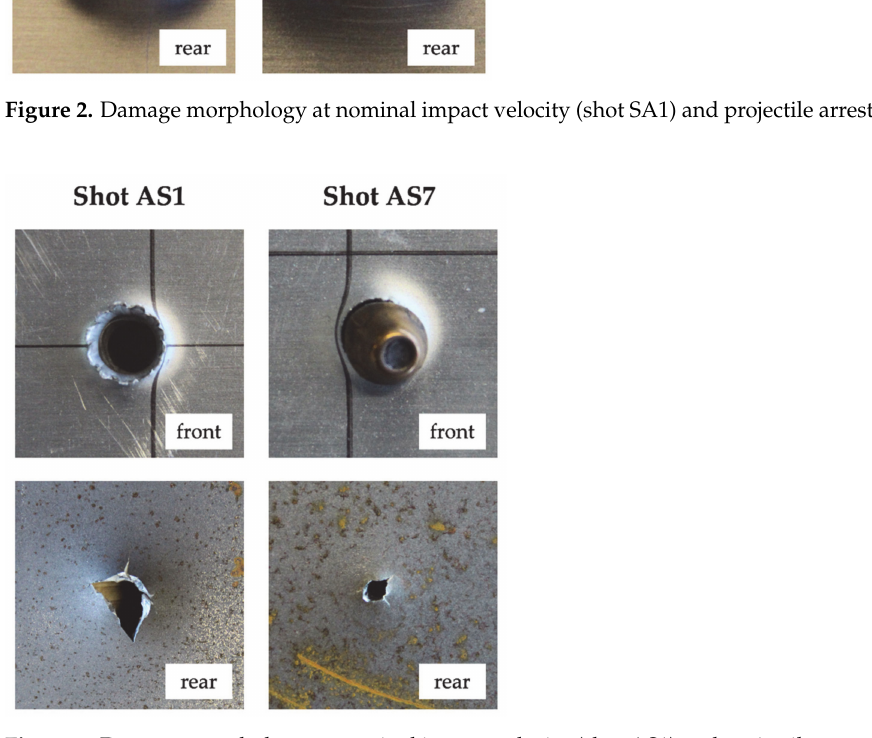
Figure 3. Damage morphology at nominal impact velocity (shot AS1) and projectile arrest (shot